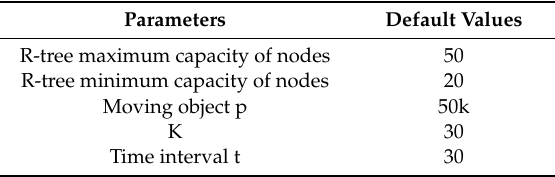
Table 2. Default parameter settings for comparative